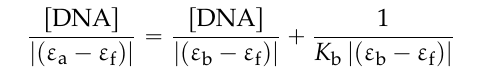
Figure 1. Electronic spectra changes of TCPC (10 μ M) upon addition of ct-DNA ( r = [DNA]/[TCPC] = 0, 0.5, 1, 1.5, 2, 2.5) in Buffer I; the inset is the plot of [DNA]/ | ( ε a − ε f ) | vs. [DNA].